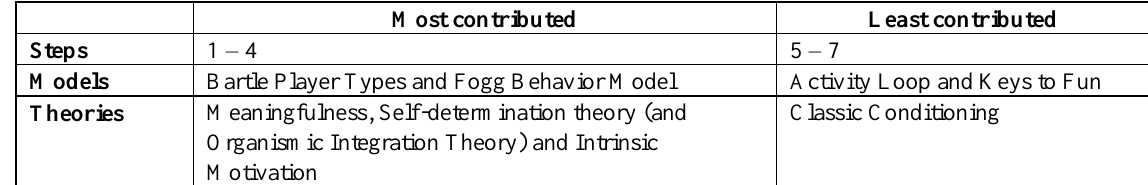
Table 2. Results of (not) contributing components of